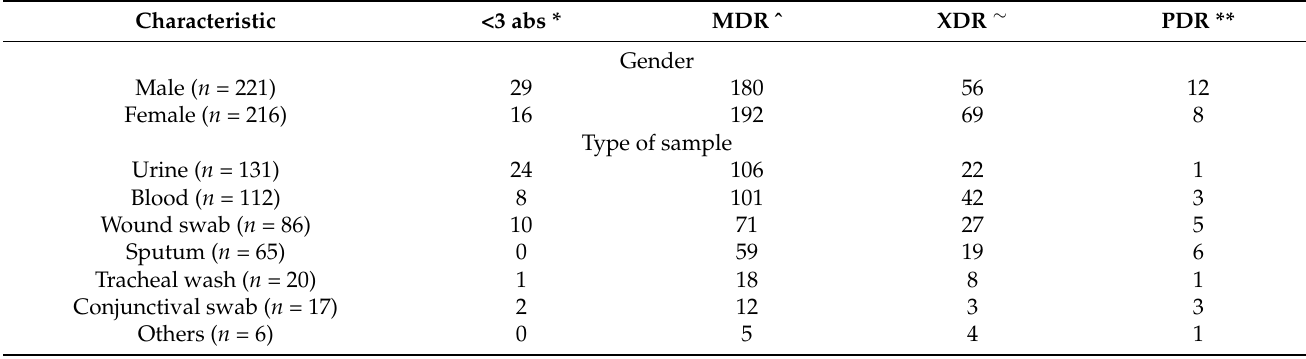
Table 4. Distribution of numbers of multidrug-, extensively drug-, and pan-drug-resistant isolates among different categories of